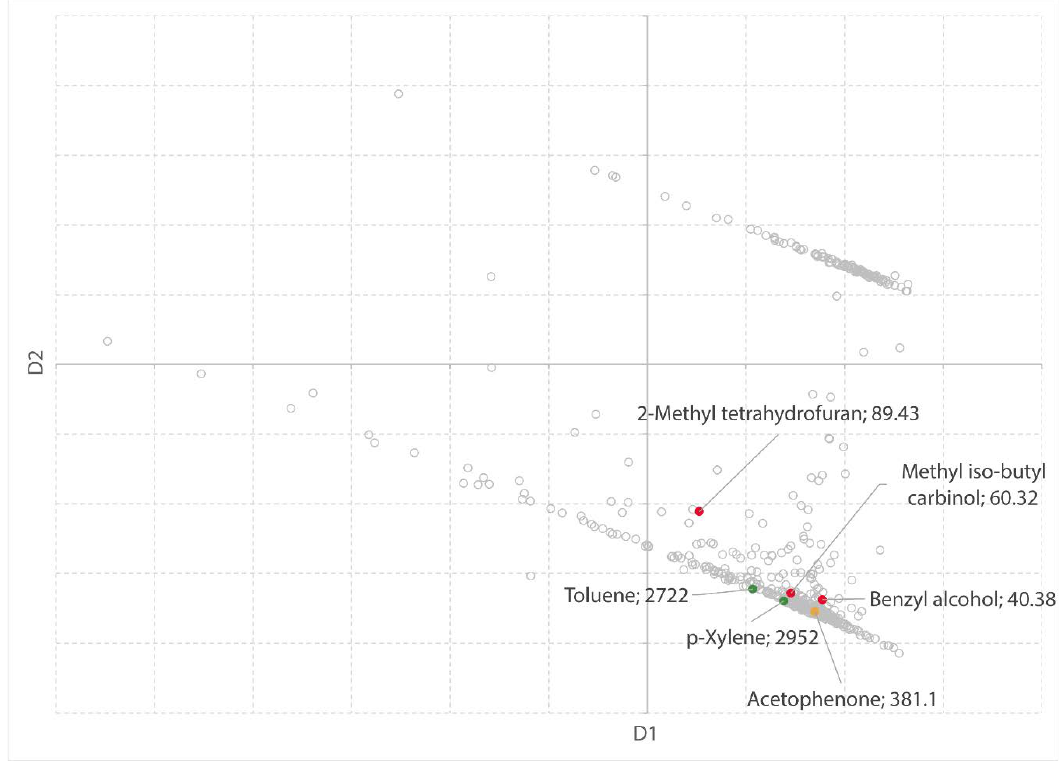
Figure 9. MDS plot with solvents highlighted in green (= high S), amber (= medium S), and red (= low S). Solvent names and S values are shown as labels in the chart.